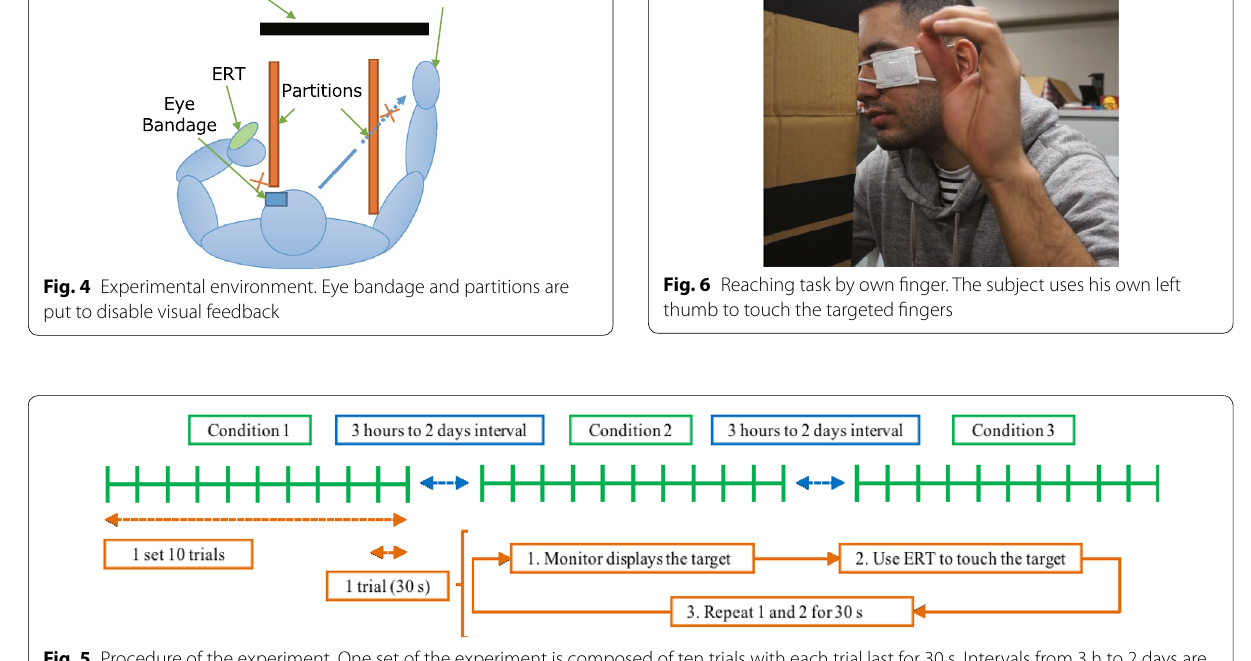
Fig. 5 Procedure of the experiment. One set of the experiment is composed of ten trials with each trial last for 30 s. Intervals from 3 h to 2 days are inserted between two experimental sets. Each experiment set is done under only one condition, and conditions are switched repeatedly in order